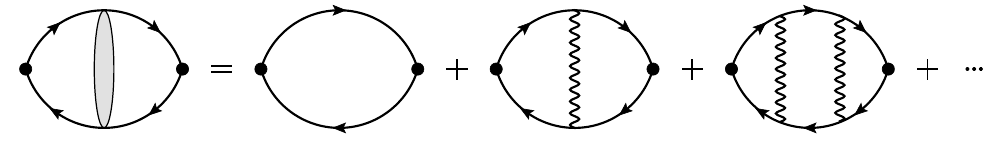
Figure 18 . Bubble diagrams for w + w (cid:0) . The ladder diagrams from the exchange of Coulomb photons must be summed to all